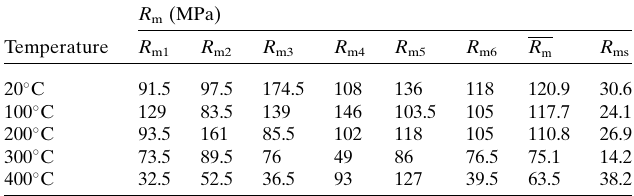
Table 4 Tensile strength of TIG joints.